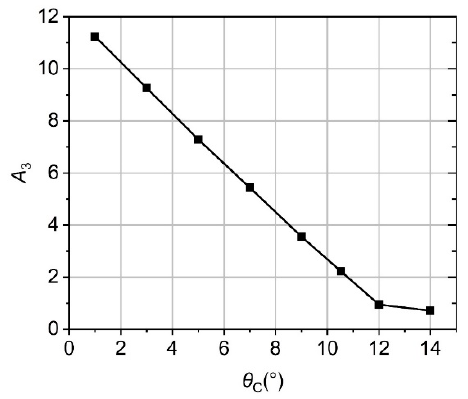
Figure 5. Absolute value of the angle between the fourth shock and the horizontal direction.